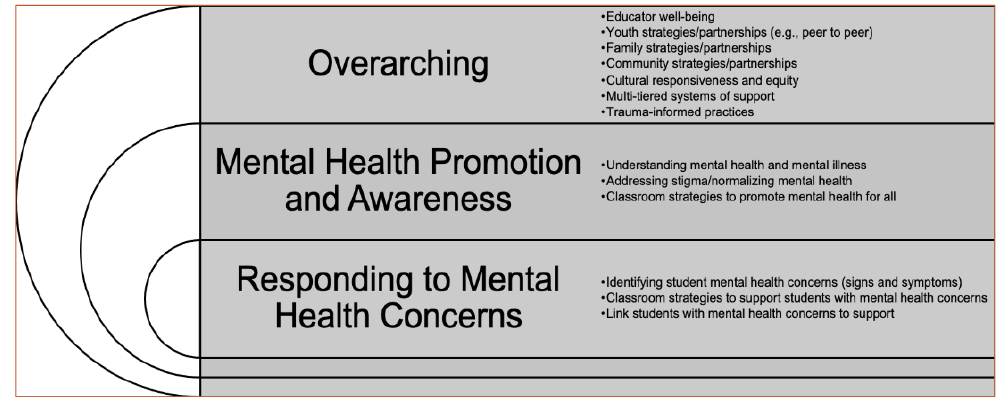
Figure 2. Proposed curriculum content following initial brainstorming session .